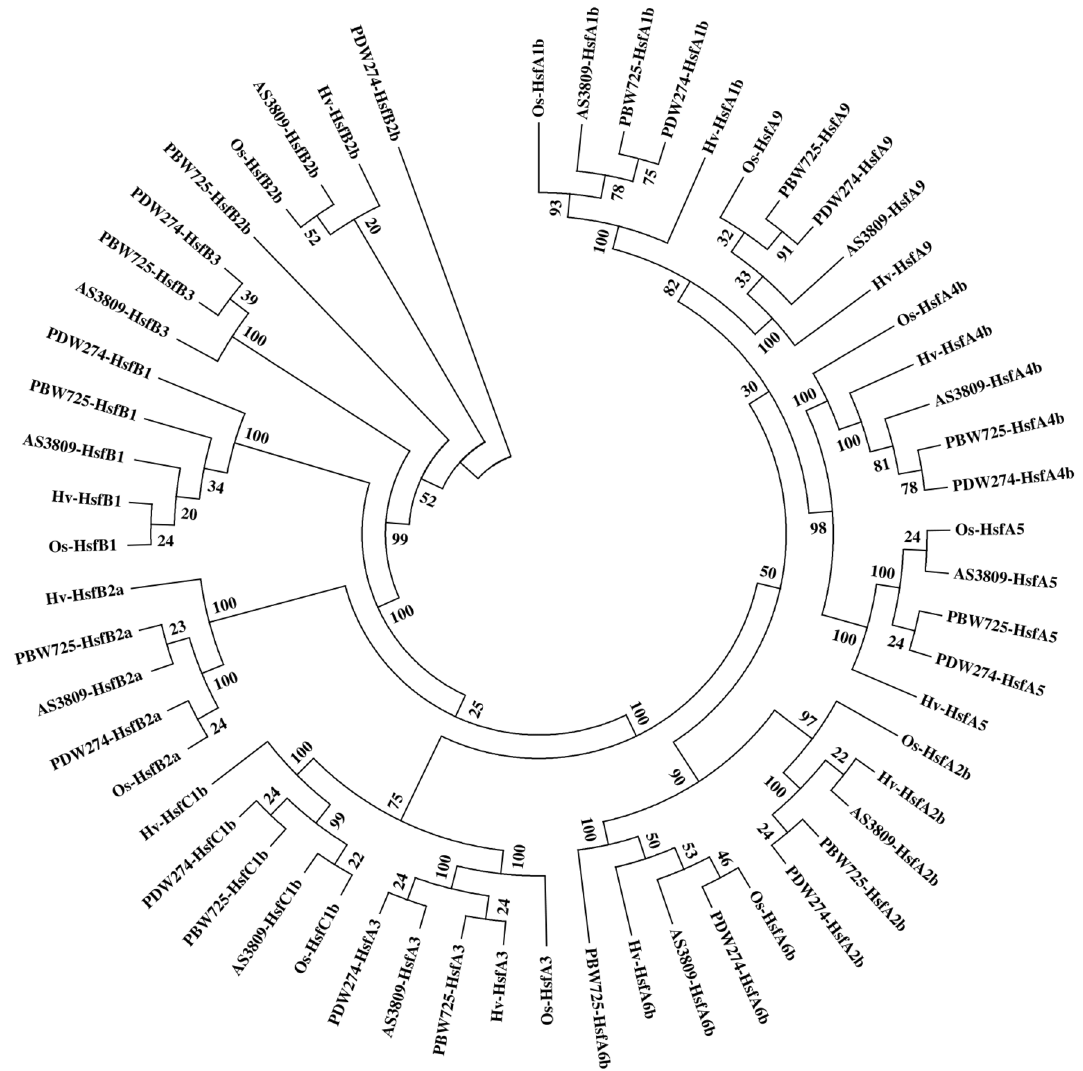
Figure 5. Phylogenetic analysis of HSF gene family of rice, barley, diploid, tetraploid, and hexaploid wheat. Numbers represent bootstrap